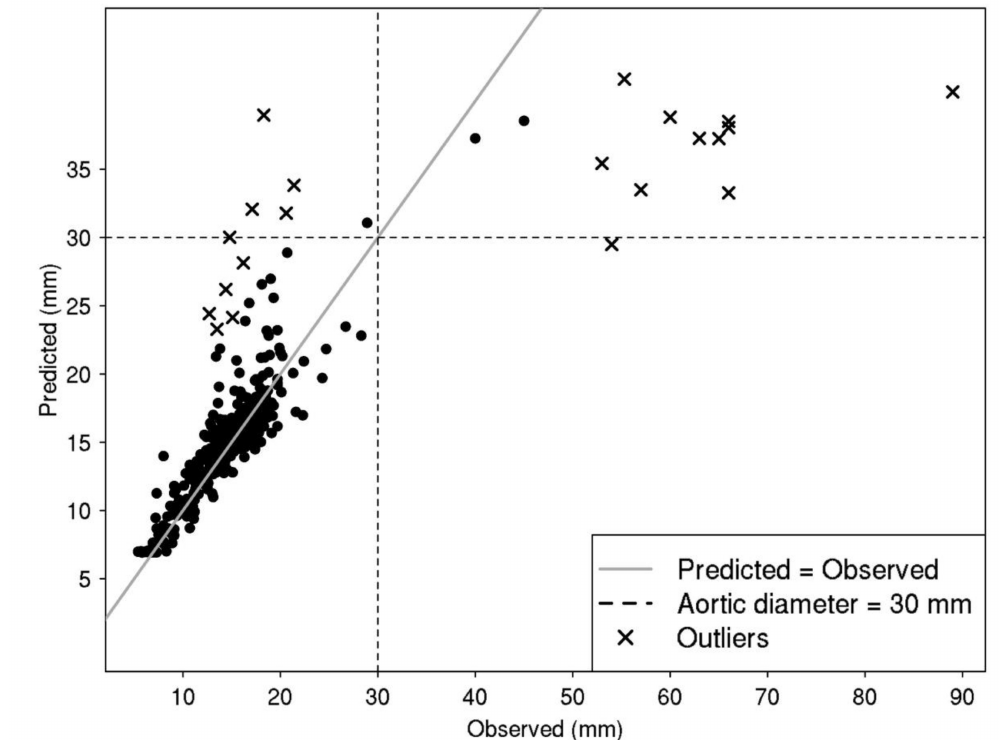
Figure 2. Prediction accuracy of the aortic diameter using the best